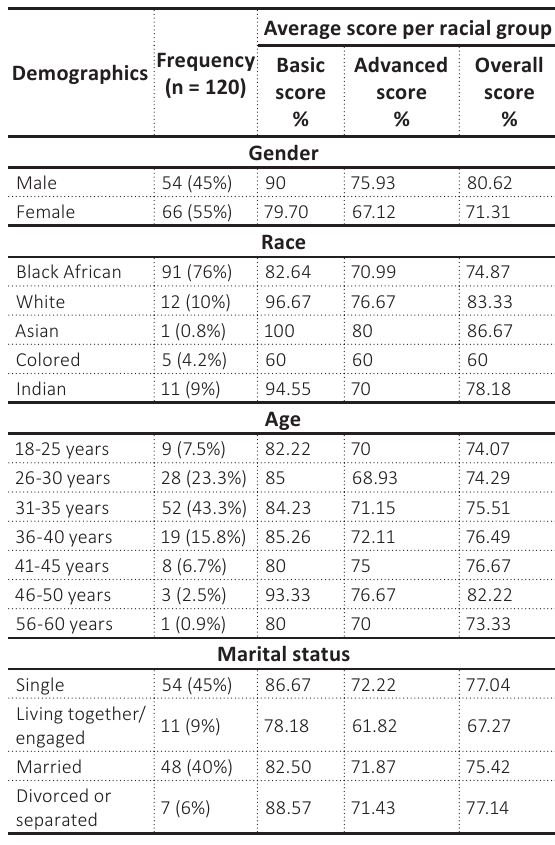
Table 1. Demographic data of the